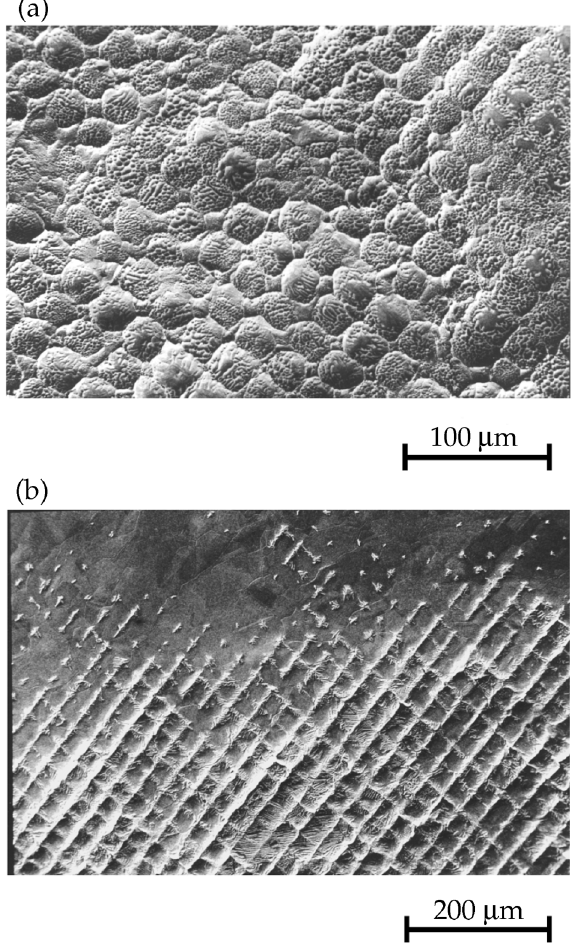
FIG. 14. SEM image of the fracture surfaces from 600 ± C dif- fusion bonded parts that had been diamond fly cut. (a) Re- gion of good bonding showing dimples spaced approximately 25 m m apart. (b) Transition region between good bonding (bot- tom of micrograph) and poor bonding (top of micrograph) show- ing ridge-to-ridge asperity contact in a regular array, which was caused by the contact of machining grooves placed approxi- mately at right angles to each other.